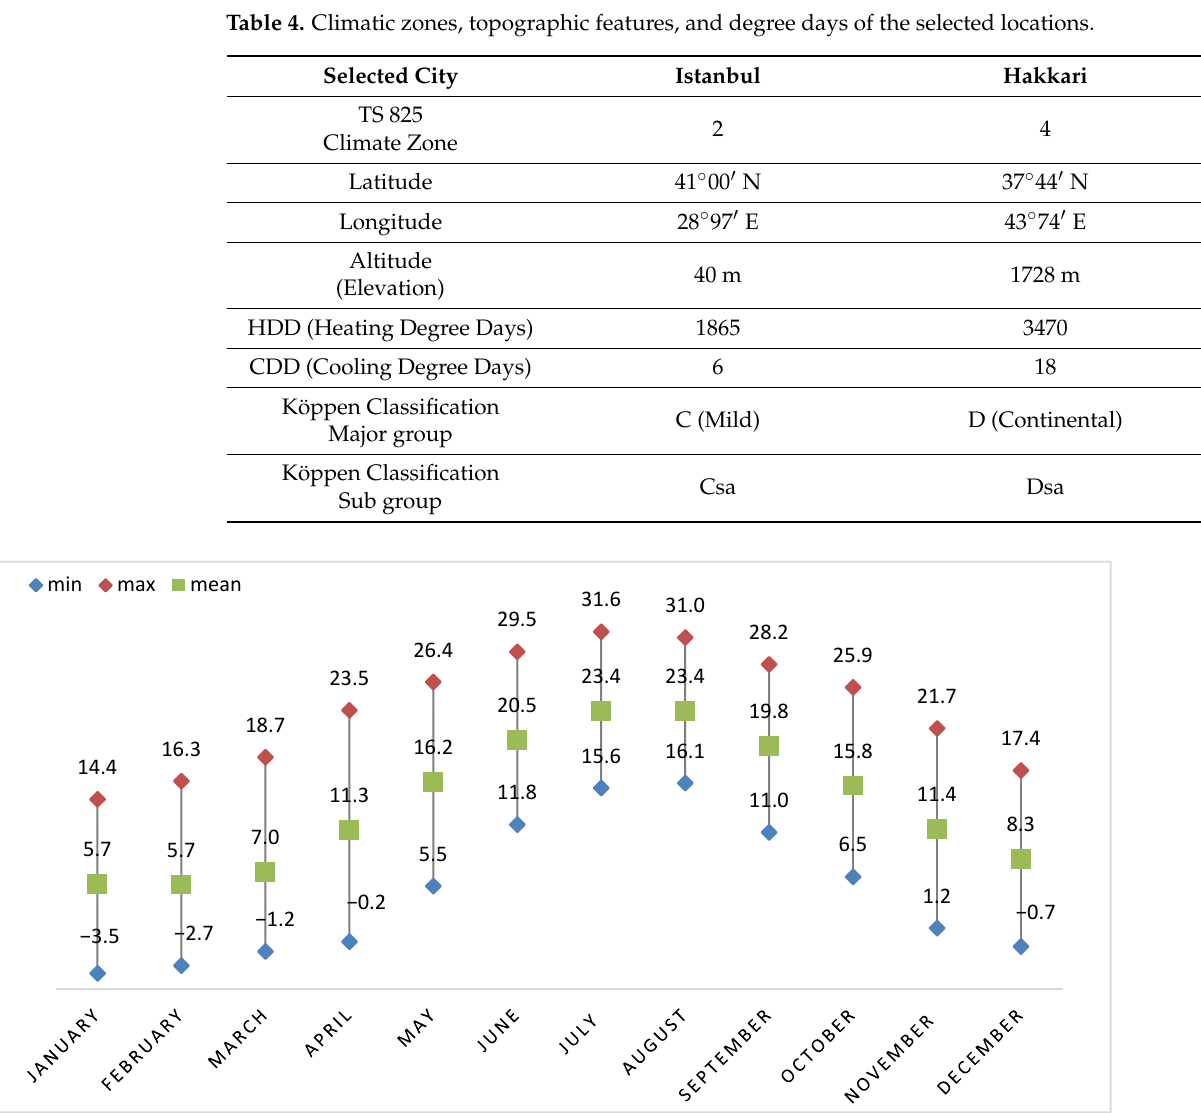
Figure 3. Mean, minimum, and maximum monthly temperatures for Istanbul .